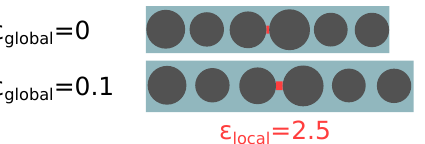
Figure 9. Mechanical strain enhancement for incompressible metal particles, i.e., E m /E p = 0 (exaggerated